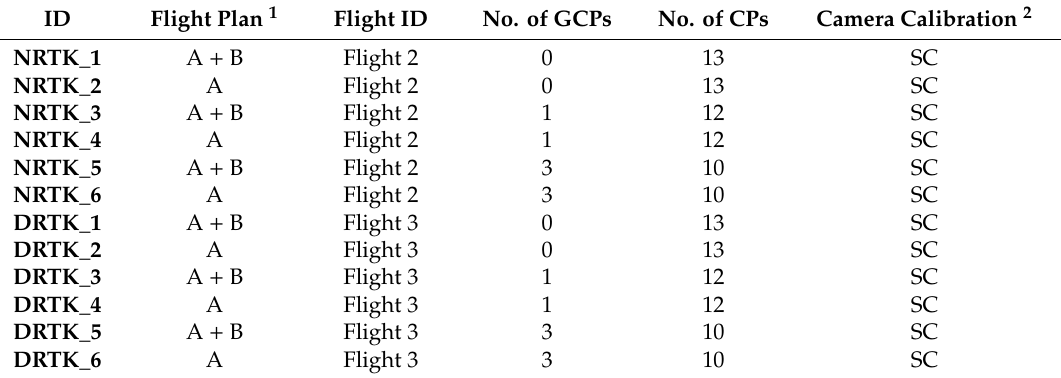
Table 9. RTK processing strategies for Flight 2 (NRTK) and Flight 3